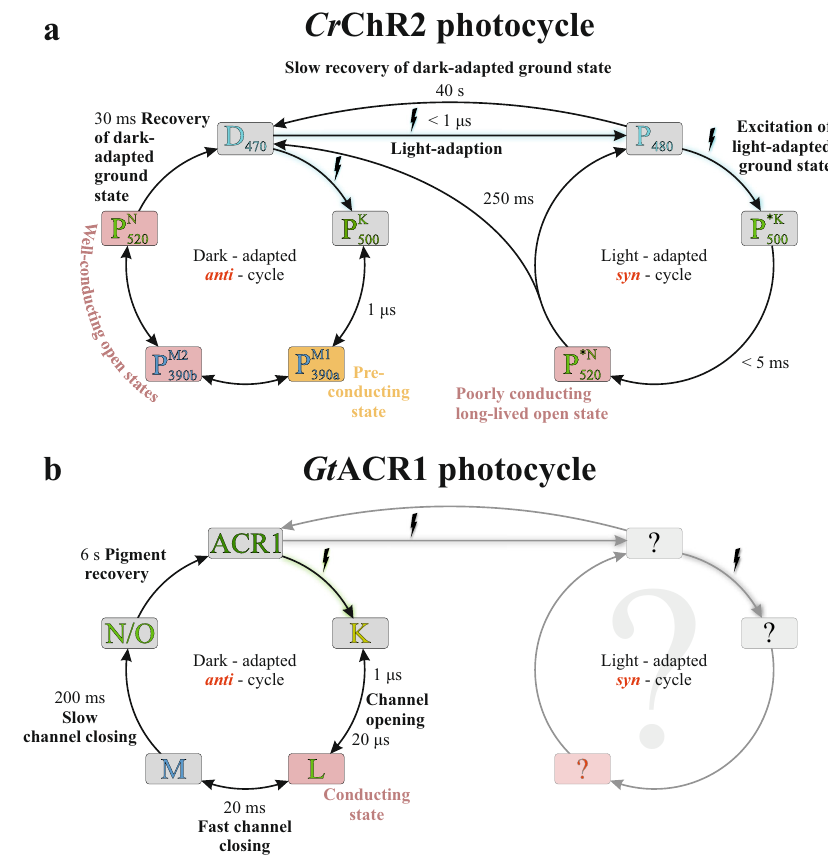
Fig. 1 Photocycle models of Cr ChR2 and Gt ACR1. a Model of the branched photocycle of Cr ChR2 (reproduced and modi fi ed from Kuhne et al. 15 ). The “ dark-adapted ” cycle (left) exclusively comprises a C = N- anti -conformation of the retinal and two well-conducting open states that decay relatively fast. In the “ light-adapted ” ground state (right), the retinal has a 13- cis ,C = N- syn conformation, and its photoproducts comprise a poorly conducting open state that decays at a slower rate. During continuous illumination, molecules are accumulated in the syn -cycle, which causes the inactivation of Cr ChR2. b Current photocycle model of Gt ACR1 (reproduced and modi fi ed from Sineshchekov et al. 24 ), showing the L -intermediate state as the open state followed by M and N/O state. The question of the existence of a branched photocycle as in Cr ChR2 is a topic of this